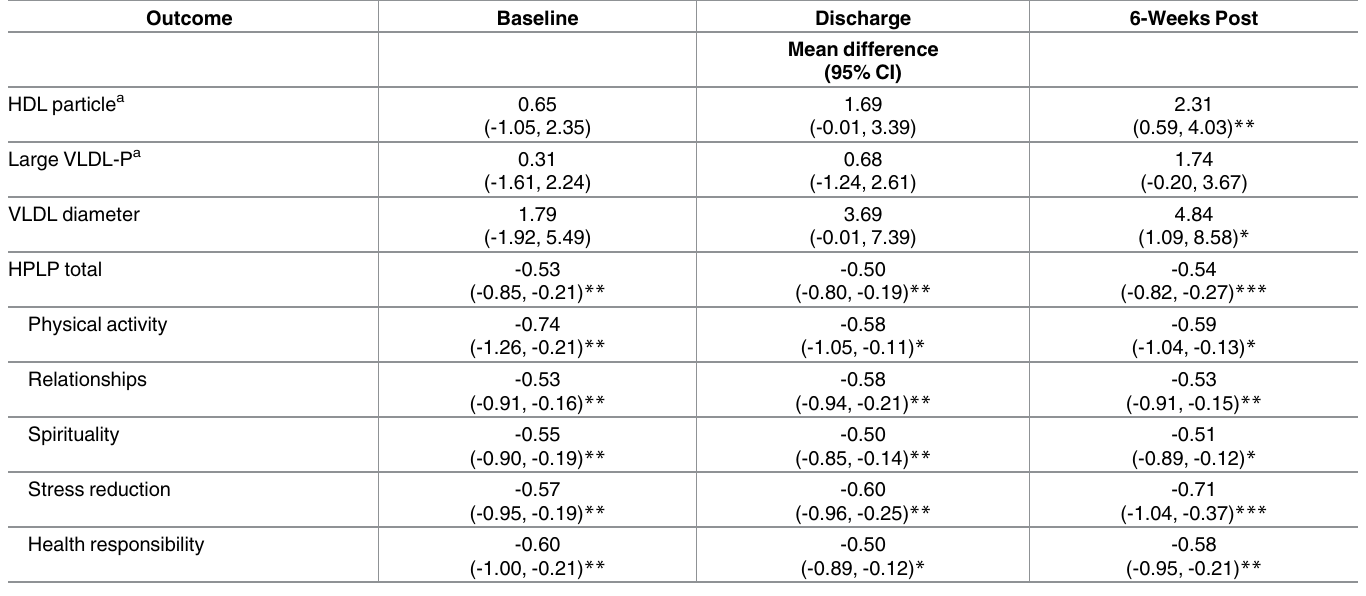
Table 2. Estimated mean differences between caregiversand controls for the main outcomes, according to mixed model repeated measures analysis.